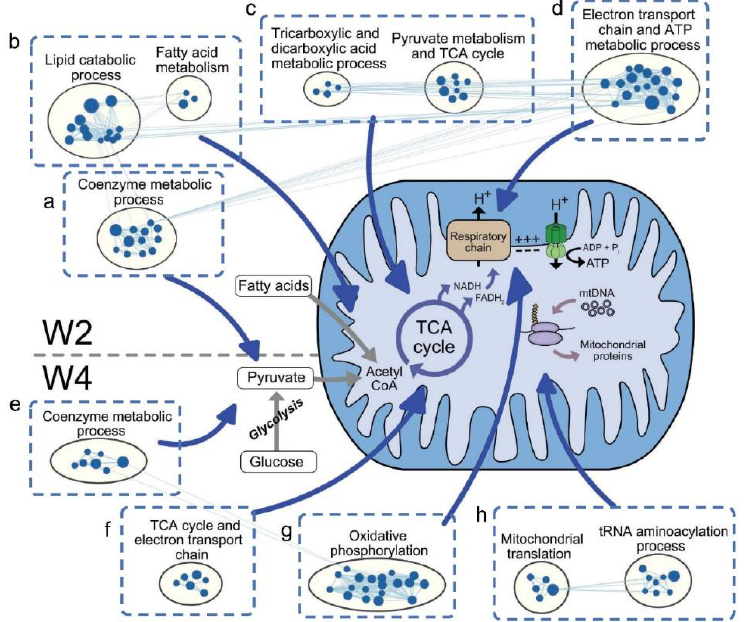
Figure 4. Downregulation of mitochondrial energetics-related gene clusters in thyroid glands of Xb130 − / − mice at W2 and W4. Enrichment results from GSEA were mapped as a network of gene sets. Blue nodes represent downregulated gene sets in Xb130 − / − mice.